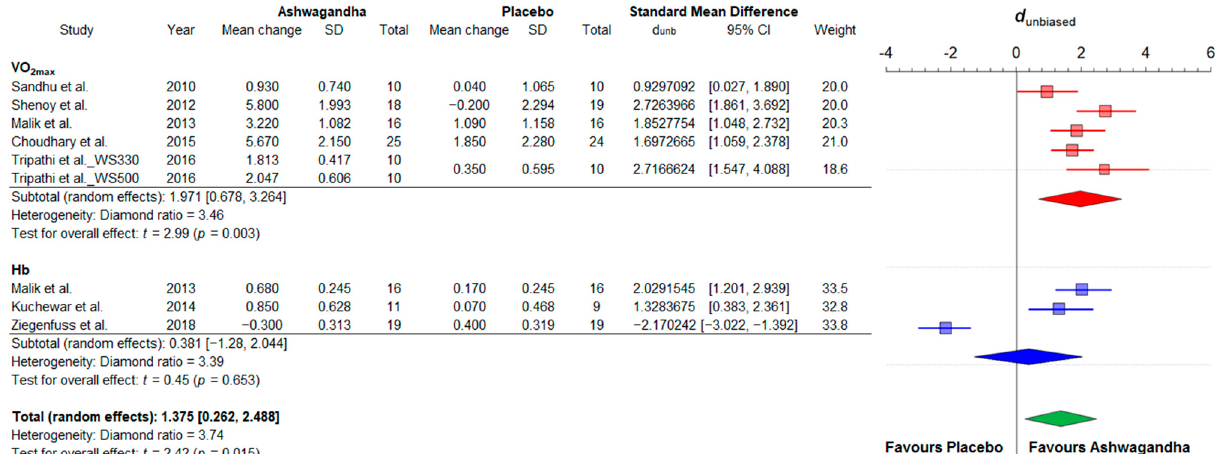
Figure A1. Forest plot depicting the standardized mean differences from a meta-analysis of all studies (including outliers) comparing groups with Ashwagandha or placebo on cardiorespiratory fitness. Colored squares represent the d unb for individual trials, while colored and green polygons depict the meta-analytic d unb for the indicated subgroups and for the overall (total) results, respectively. Horizontal lines represent the 95% confidence intervals for the data. Hb: blood hemoglobin concentration; VO 2max : maximum oxygen uptake; WS330: Withania somnifera 330 mg; WS500: Withania somnifera 500 mg.